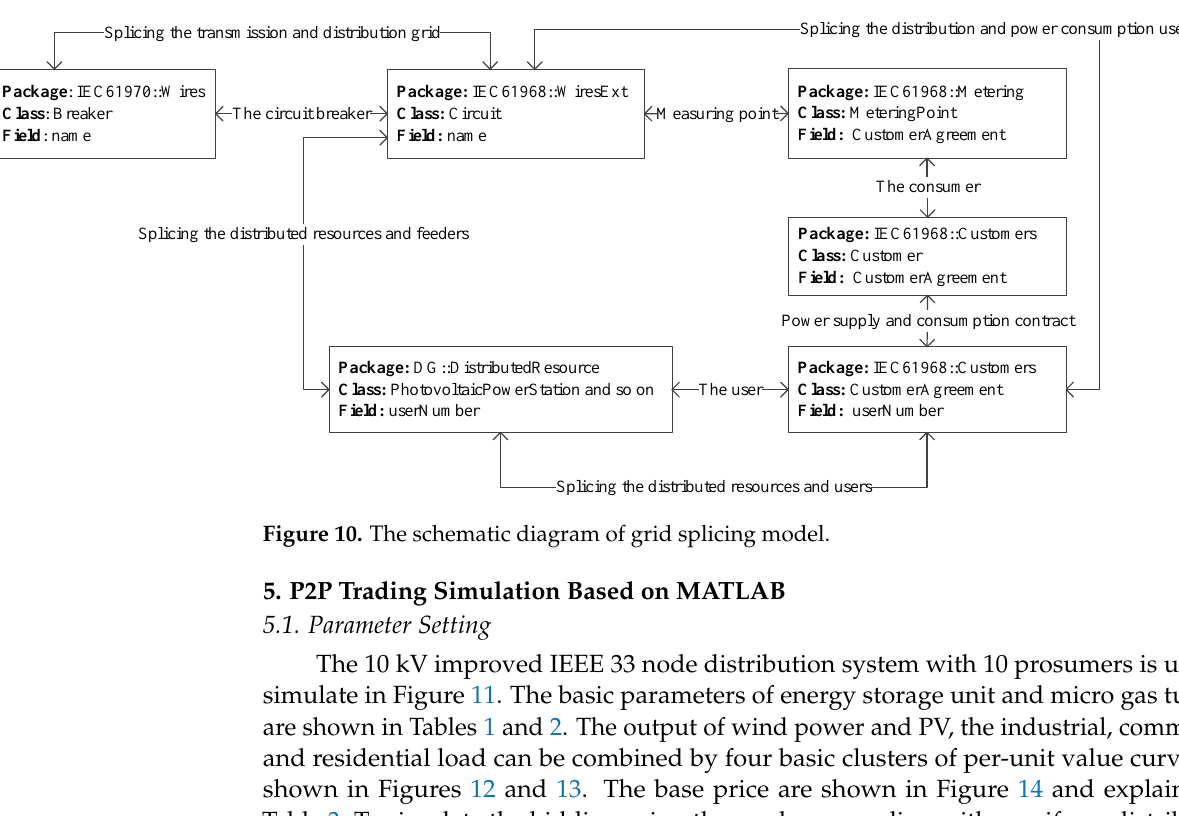
Figure 11. Simulation model of IEEE 33-bus distribution system. Table 1. Basic parameters of the electrochemical energy storage. Parameters